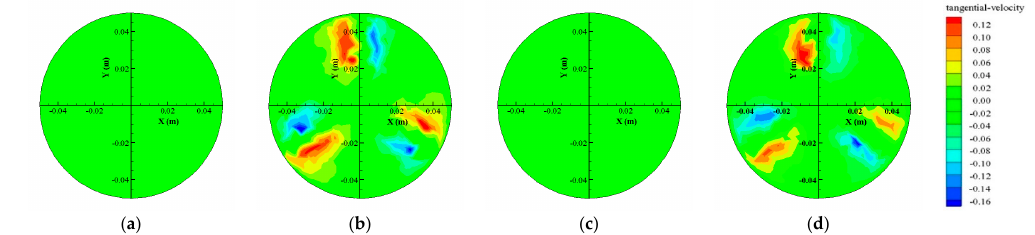
Figure 11. Circumferential flow velocity distributions of the upstream sections of capsules. ( a ) Z = 0.105 m, L/D = 2; ( b ) Z = 0.075 m, L/D = 2; ( c ) Z = 0.105 m, L/D = 1.67; ( d ) Z = 0.075 m, L/D = 1.67. L / D =